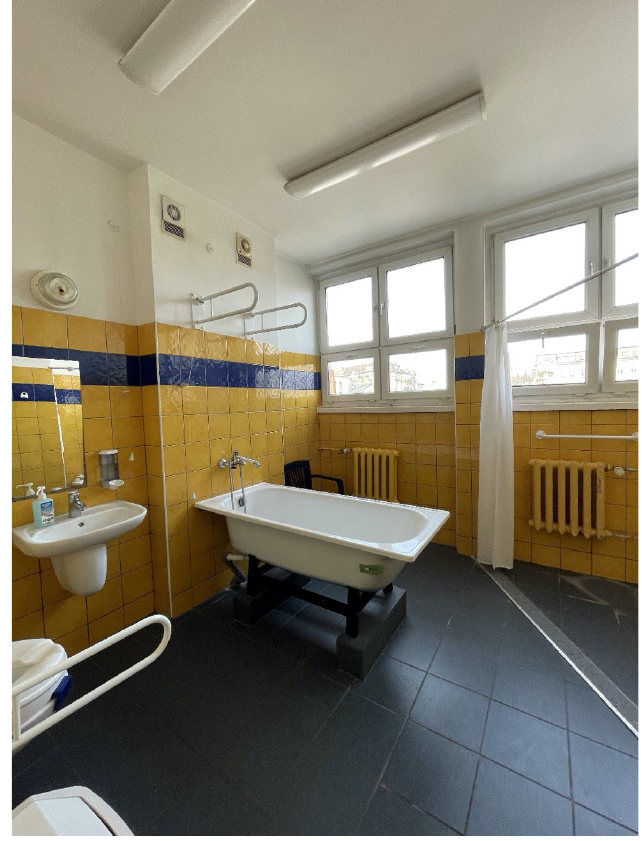
Figure 5 . Orthopaedic hospital in Poznan, source: author’s own material .